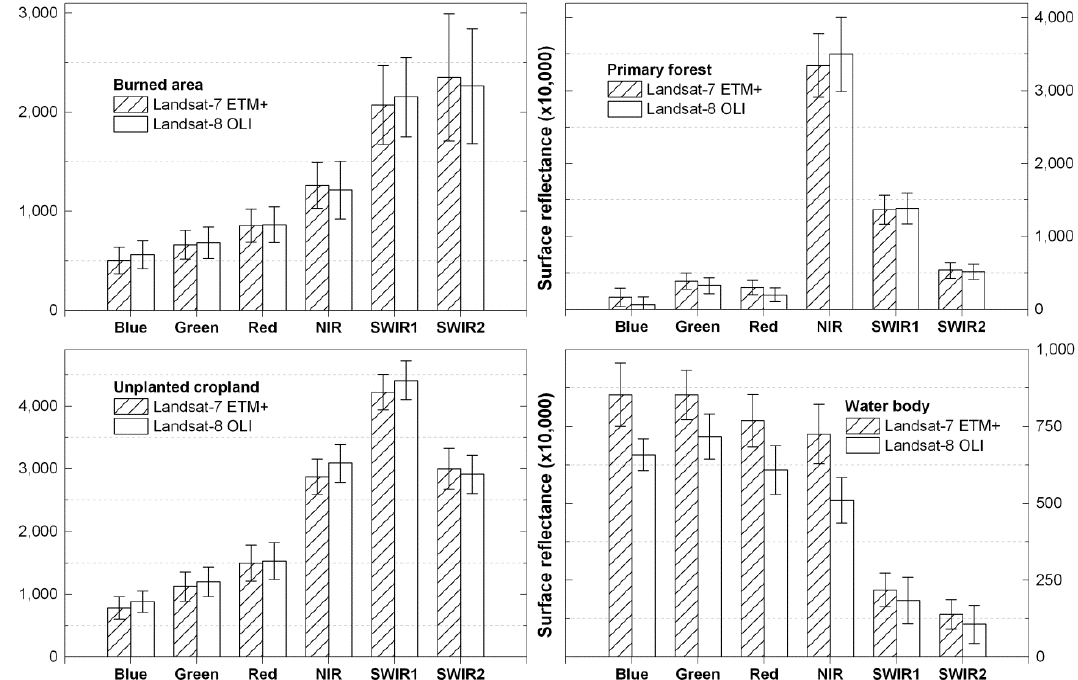
Figure 5. Band differences of Landsat-7 ETM+ and Landsat-8 OLI images (25 March 2013 and 27 March 2013) for four land-cover types (primary forest, unplanted cropland, swidden field and water body).